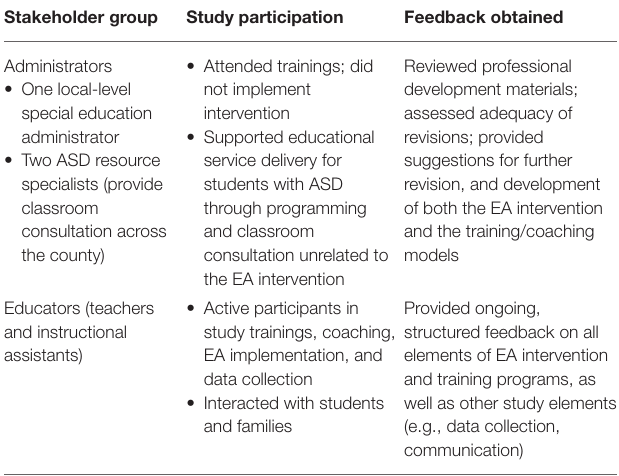
TABLE 2 | Demographic information. Stakeholder